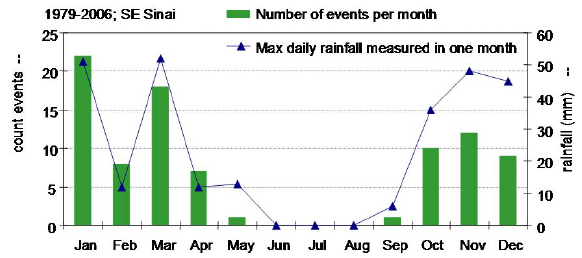
Fig. 2. Distribution of rainfall and storm events from 1979–2006.